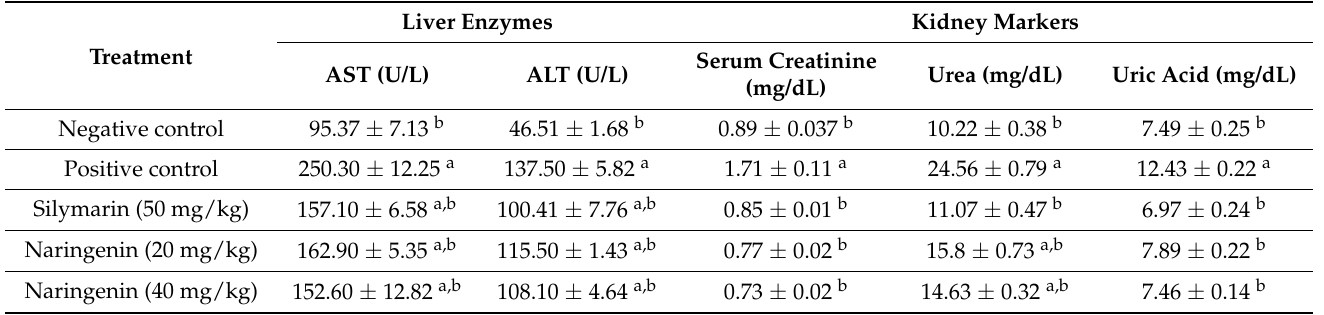
Table 1. Effects of naringenin on the liver and kidney markers in CCl 4 -administered rats. Liver Enzymes Kidney Treatment